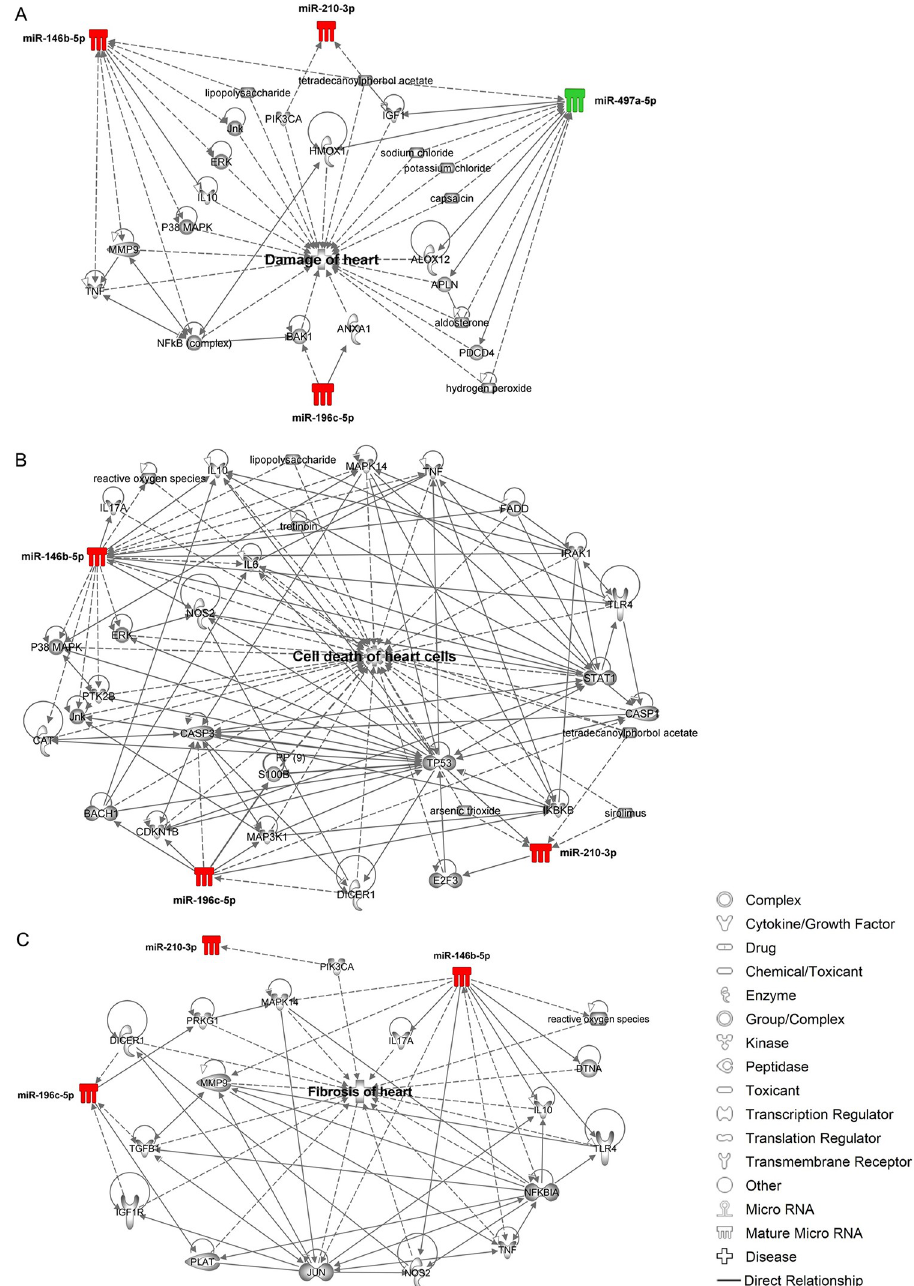
Fig 8. Target prediction analysis for Bz+PTX treated group. (A) Damage of heart pathway. (B) Cell death of heart cells pathway. (B) Fibrosis of heart pathway. The red color indicates miRNA upregulation, while the green color indicates miRNA downregulation. Full lines indicate a direct relationship, while dashed lines indicate an indirect